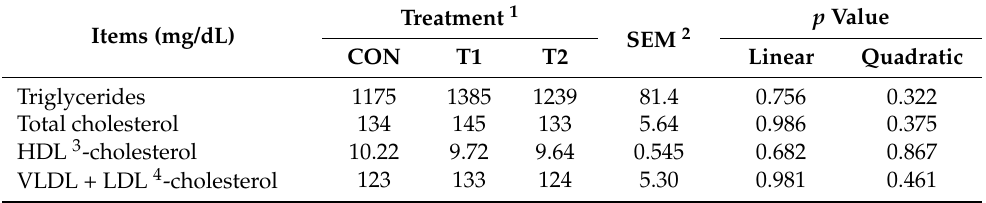
Table 6. Effect of FPNE supplementation on serum lipid parameters in laying hens at 48 week of age.